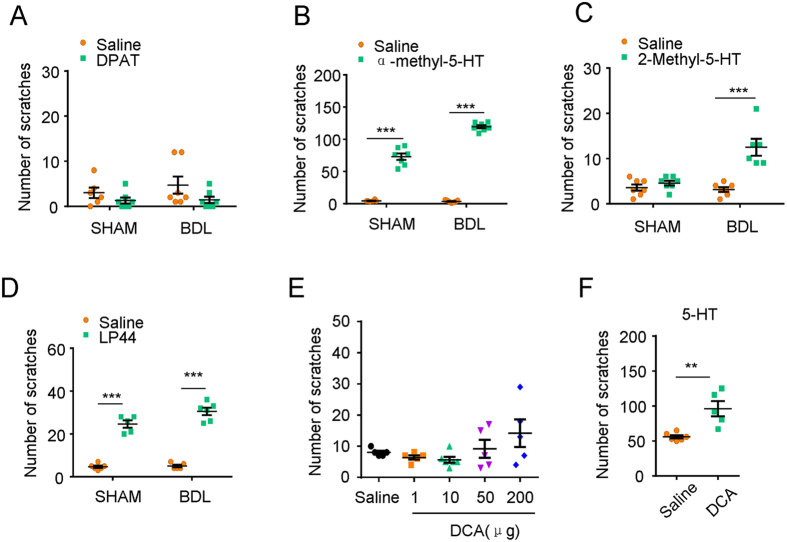
The effects of intradermal injection of 5-HT receptor agonists in sham and BDL rats.(A–D) The scratching response was induced by intradermal (i.d.) injection of 5-HT1A receptor agonist DPAT (A) 100 μg, 5-HT2 receptor agonist α-methyl-5-HT (B) 100 μg, 5-HT3 receptor agonist 2-Methyl-5-HT (C) 100 μg, 5-HT7 receptor agonist LP44 (D) 100 μg into cheek of sham and BDL rats 15 days after BDL surgery (n = 6–8 per group). (E) No obvious scratching behavior induced by i.d. injection of DCA (1 to 200 μg into the cheek of naïve rats (n = 6–8 per group). (F) 15 minutes after i.d. injection of DCA (50 μg), the rats were given an i.d. injection 5-HT (20 μg) into the cheek. 5-HT-induced scratching behavior was significantly enhanced by DCA in naïve rats (n = 6–8 per group) (**P < 0.01, ***P < 0.001 vs. vehicle values and analyzed by Student’s t-test or one-way AVOVA following Bonferroni post hoc test).